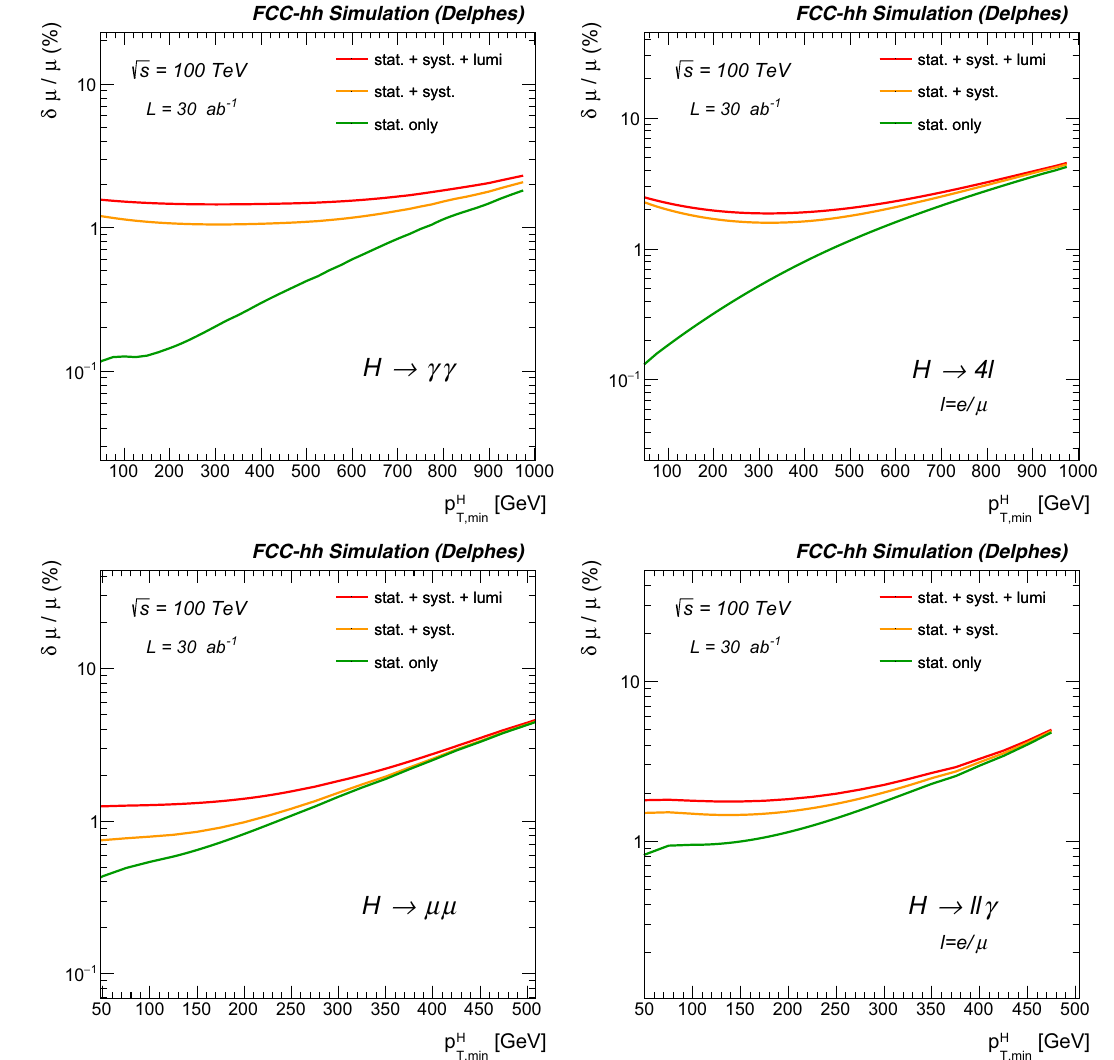
Fig. 4.5 Projected precision for the rate measurement of various Higgs final states, in the gg → H production channel. The label “lumi” indicates the inclusion of a 1% overall uncertainty. The systematic uncertainty “syst” is defined in the text ¯ precise knowledge of B ( H → b b ) , and the confirmation of the SM predictions for the Zt ¯ t vertex, the t ¯ tH/t ¯ tZ ratio should therefore allow a determination of the top Yukawa coupling to